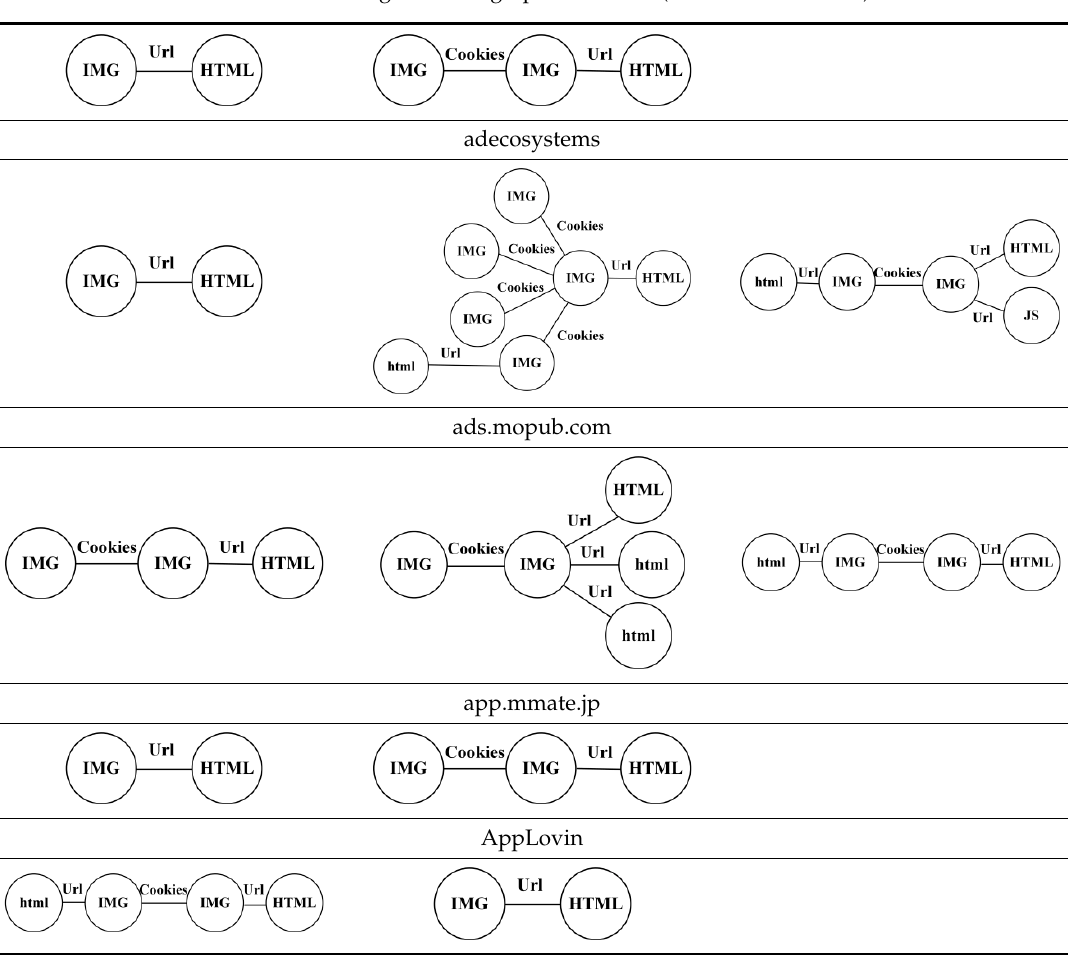
Table 1. Advertising behavior graphs of ad libs (with ad lib as